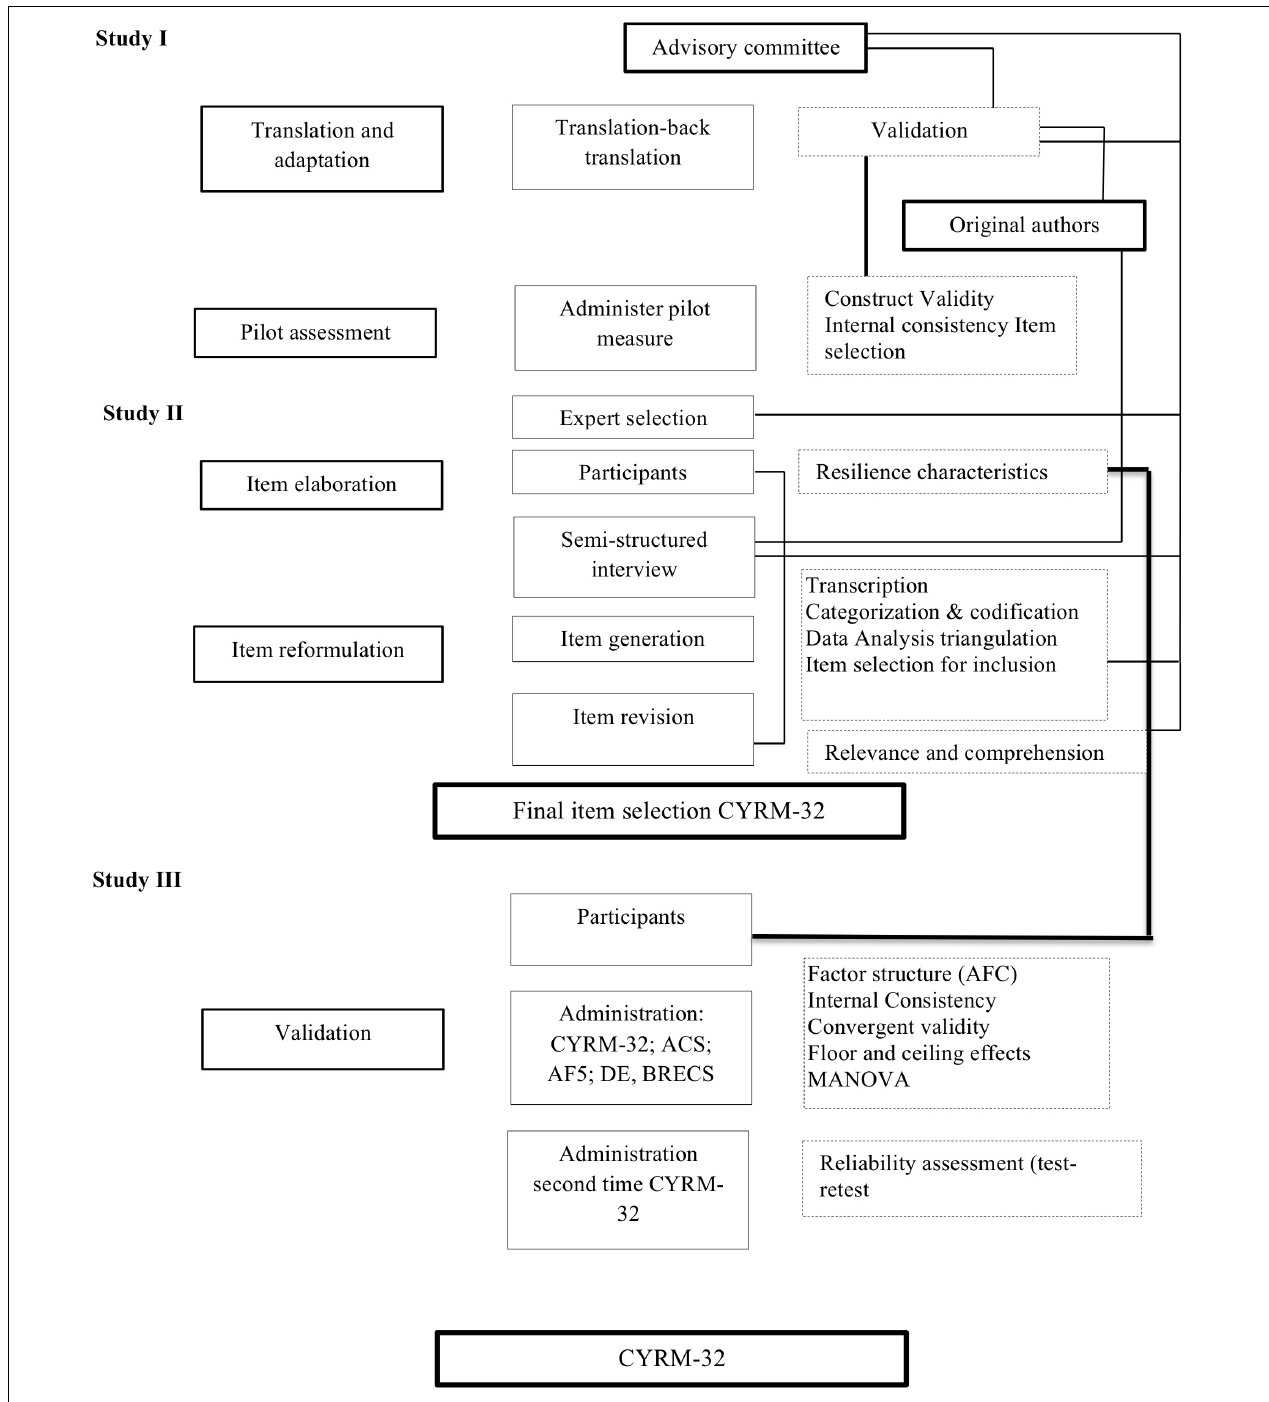
FIGURE 1 | Procedure